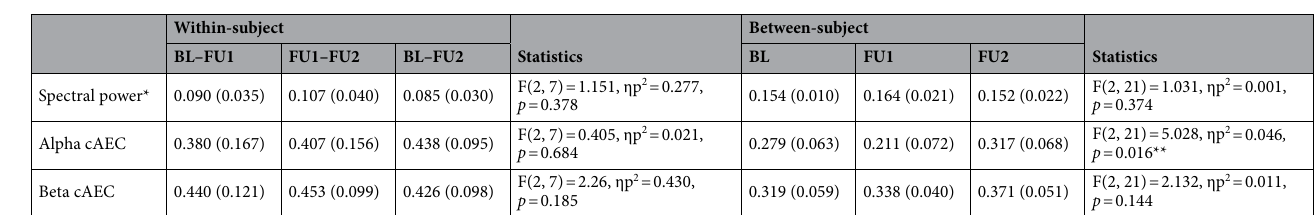
Table 1. Within- and between-subject consistency values, expressed as mean (standard deviation). Note that in case of spectral power, lower Kolmogorov–Smirnov 2 test statistic values represent a higher consistency. In case of the functional connectivity analyses (leakage corrected AEC), higher Spearman’s rho values indicate a higher consistency. BL baseline, FU1 follow-up 1, FU2 follow-up 2, ηp 2 partiel eta squared (effect size); Statistics on correlation values over time was performed using repeated measures ANOVAs. *Consistency values expressed as Kolmogorov–Smirnov 2 test statistic. **Post-hoc paired t -tests; BL–FU1 t (7) = 2.53, p = 0.039; FU1–FU2 t (7) = 4.04, p = 0.005; BL–FU2 t (7) = 1.51, p =